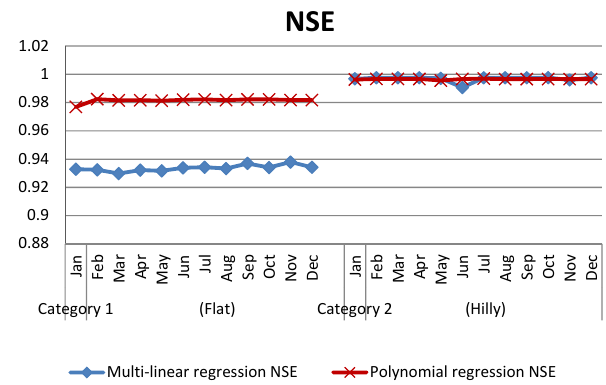
Fig. 10. NSE Performance Figure 10 NSE Performance statistics